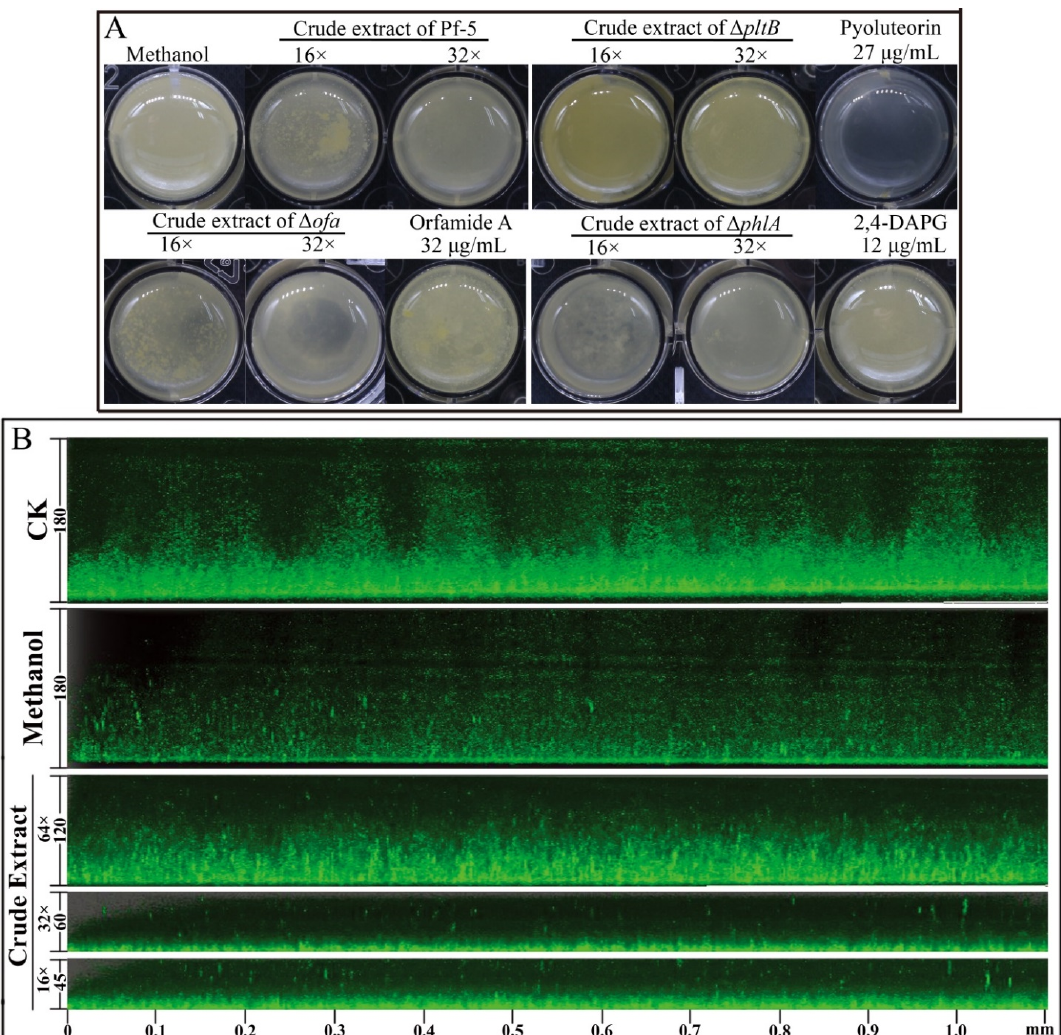
Figure 4. Effect of crude extract prepared from P. protegens Pf-5 on the biofilm formation of P. ananatis DZ-12. Bacterial cells were statistically cultured on LB medium in a 24-well plate ( A ), and in chambers in slides ( B ), at 28 °C for 48 h. For the common observation ( A ), different dilutions of the crude extract (32×, 16×) from P. protegens Pf-5 and its mutants Δ ofa , Δ pltB , and Δ phlA were used. A concentration of 27 μ g/mL pyoluteorin, 32 μ g/mL orfamide A, and 12 μ g/mL 2,4-DAPG were also used. For the fl uorescence microscope observation ( B ), different dilutions of the crude extract (64×, 32×, and 16×) from P. protegens Pf-5 were used. Representative images of the Z-stack assembly in the biofilms of cells and biofilm thicknesses were measured using a Leica SP5 confocal